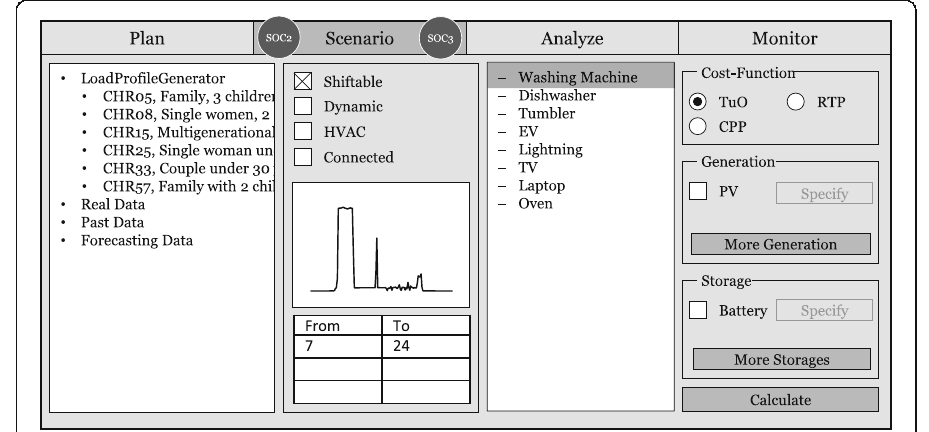
Fig. 8 Composition of a user-specific scenario (schematic